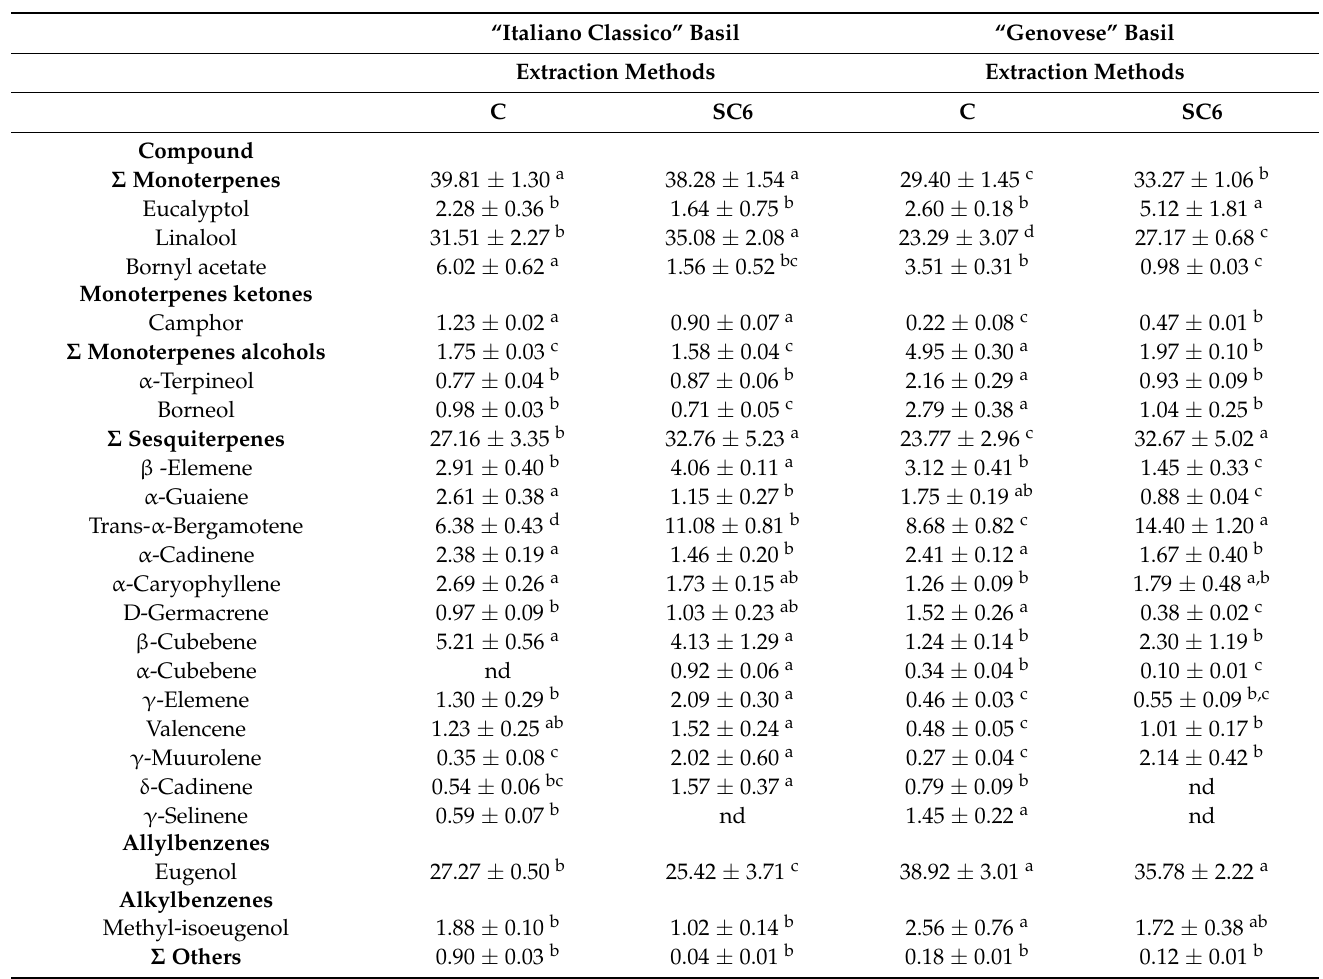
Table 3. Volatile organic compounds (relative percentage) in “Italiano Classico” and “Genovese” basil extracts obtained by different methods (C: ethanol; SC6: supercritical CO 2 + 10% ethanol). “Italiano Classico”